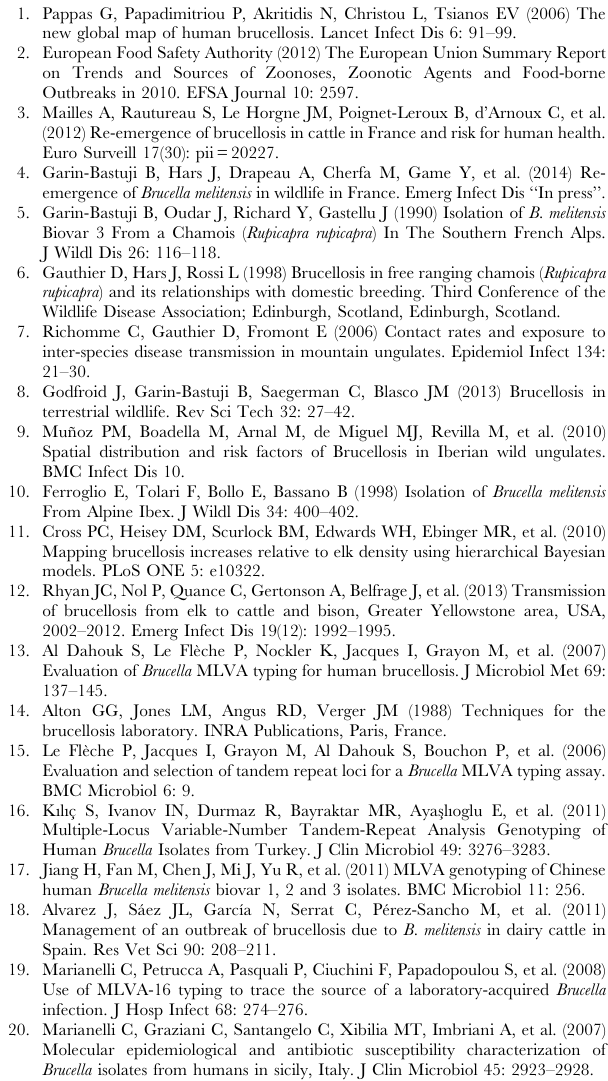
Table S1 Brucella melitensis biovar 3 strains isolated from different sources and of different geographical origins, investigated in this